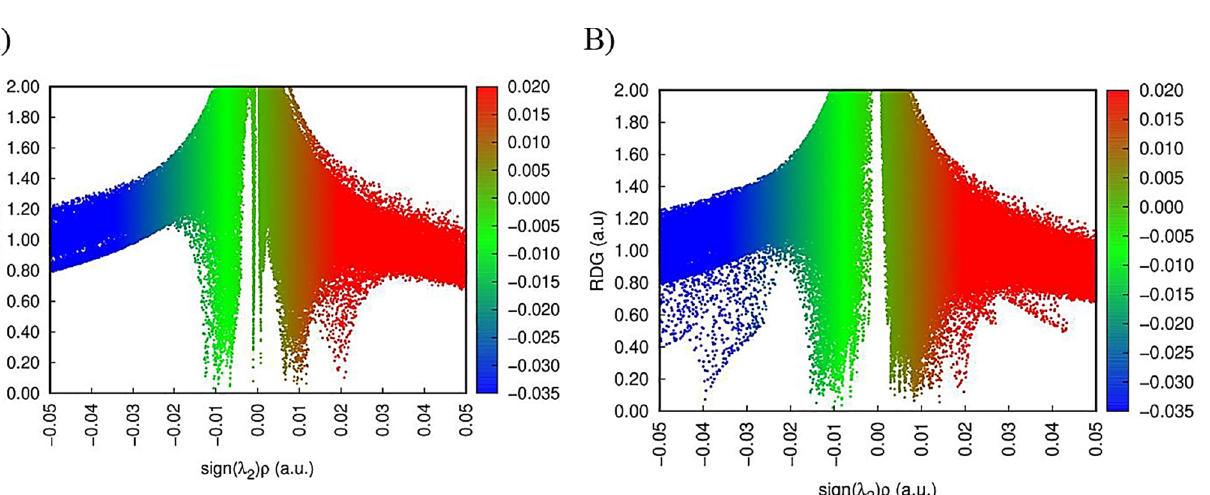
Figure 8. Graphical illustration of the reduced density gradient vs. electron density ( A , B ) and the various forms of interactions ( C , D ) of hydroxychloroquine and hydroxychloroquine sulfate com- pounds. Reproduced with permission from ref. [82]; Copyright 2021, Wiley. Farzad and coworkers also reported distinct forms of non-covalent interactions based on the color-filled RDG isosurface during the investigation of the probing impact of pol- yethylene glycol (PEG) on the adsorption mechanisms of Gemcitabine (Gem) drug on the hexagonal boron nitride (h-BN). The RDG vs. sign( λ 2 ) ρ and RDG-based NCI isosurface plots of two configurations of the drug–carrier complex were predicted by the Multiwfn program as shown in Figure 9. Because of the formation of π - π stacking between the drug